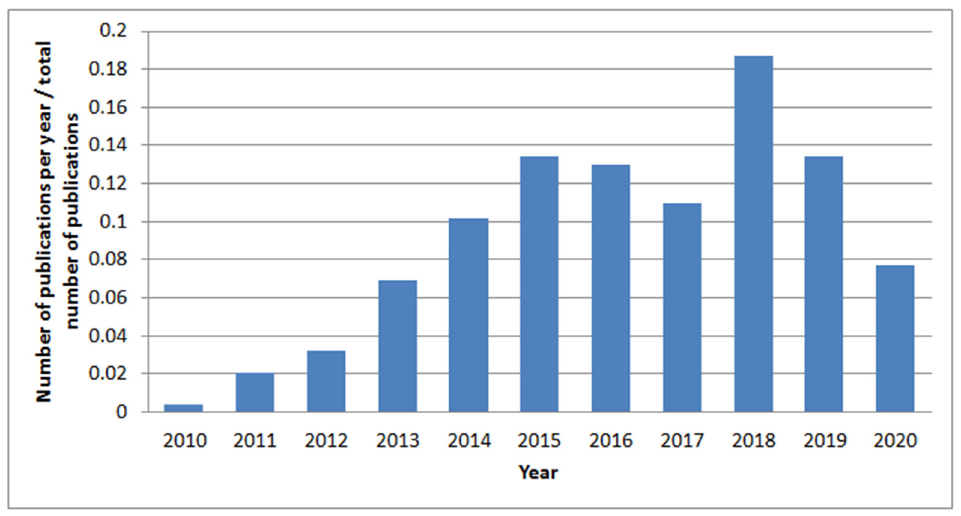
Figure 1. Number of scientific articles on “geosocial networking” OR “geosocial networks” OR “location-based social networks” in WoS by year (retrieved on March 2021). Table 1. Scientific articles published in WoS dealing with the geosocial networking topics surveyed by Armenatzoglou and Papadias [2]. The asterisk (*) in the query allows finding all words that start with the same letters (e.g. network* finds network, networks, networking, etc.).